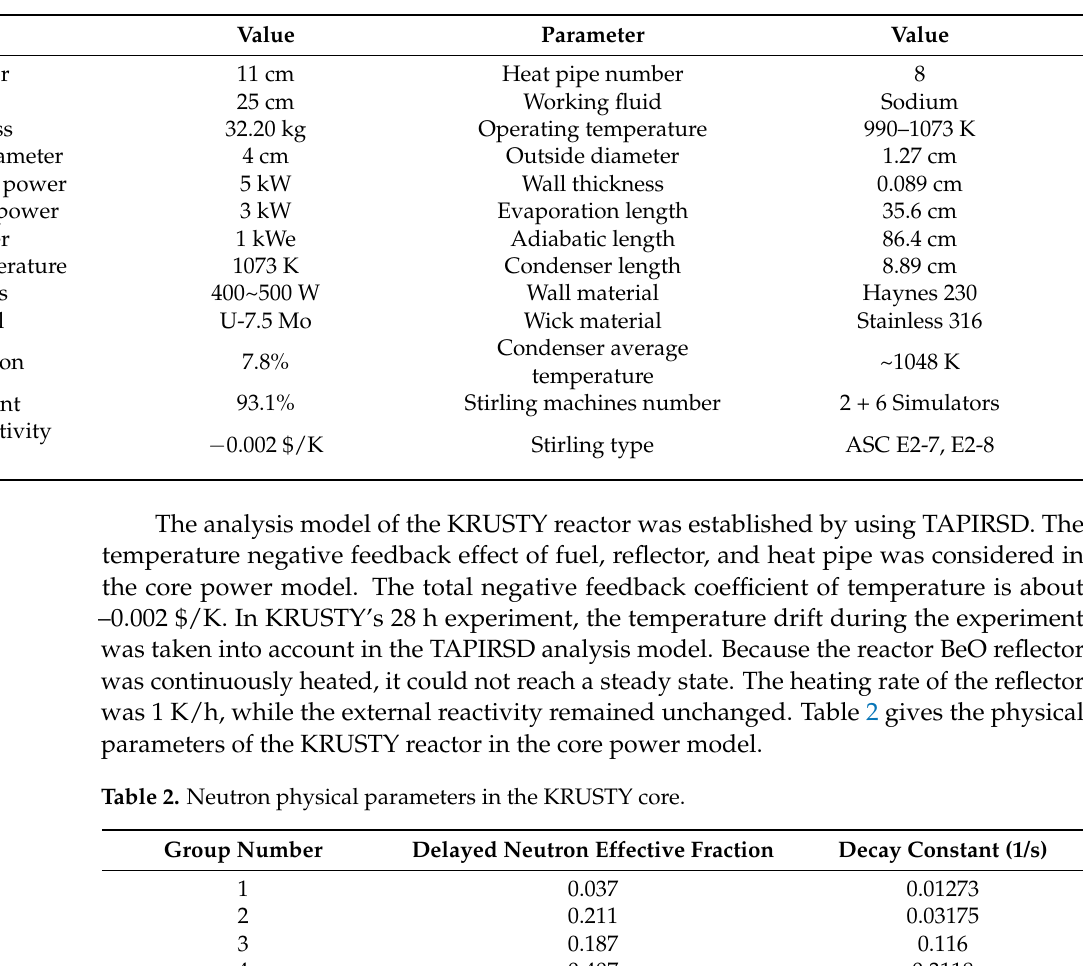
Figure 13. KRUSTY reactor configuration [31]. Table 1. The main design parameters of the KRUSTY reactor.